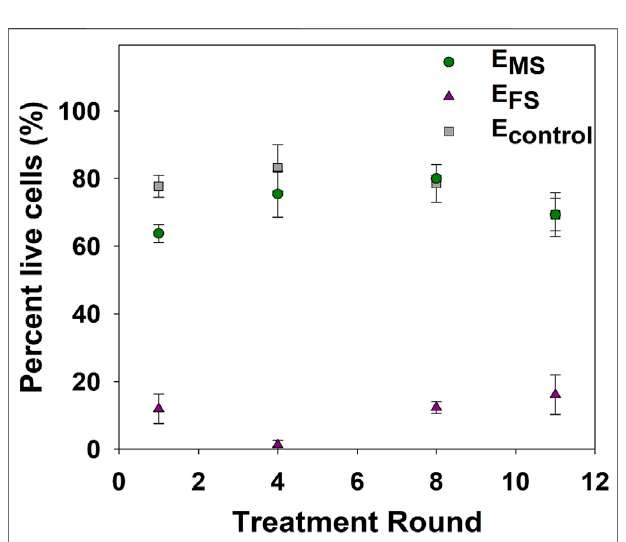
FIGURE 4 | Effect of cAMP addition on culturable cell concentration of E control andE MS culturesafter60 minofmonochloraminetreatmentatthe16th disinfection round. Error bars represent one standard deviation of at least triplicate samples. Asterisks (*) indicate statistical signi fi cance ( p -value < 0.05) compared to 0 mM cAMP addition.